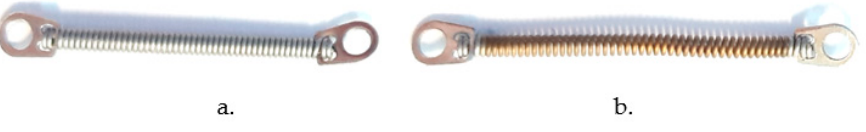
Figure 8. Ni-Ti spring after testing phase with I 1 current ( a ) and after testing phase I 2 current ( b